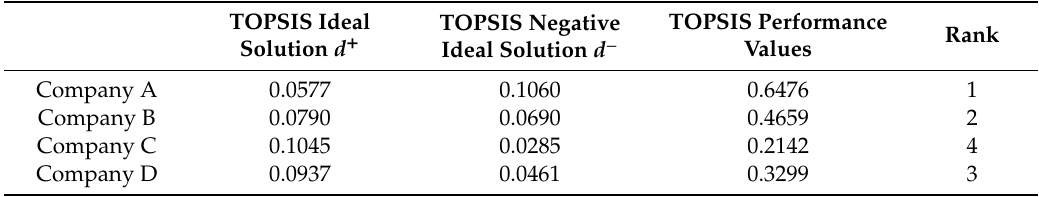
Table 9. Outcome of the